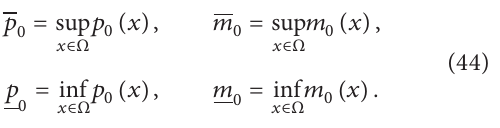
space 𝐿 2 (Ω) × 𝐿 2 (Ω) if the forcing term 𝑓 is zero. So the global attractor reduces to the single point (0,0). Since the translation transformation 𝑢 = 𝑝 − (𝛼/𝛿) , V = 𝑚 − 𝑏 0 , which means that the solutions of the cancer network converges to stable steady states as 𝑘 1 = 0 . From the analysis of the local solution in Section 3, the solution of the system (43) is nonnegative for any nonnegative initial value. Then, for 𝑘 1 ̸= 0 condition, we have 0 ≤ 𝑘 1 𝑝 2 /(𝑎 + 𝑝 2 + 𝑏𝑚) ≤ 𝑘 1 .